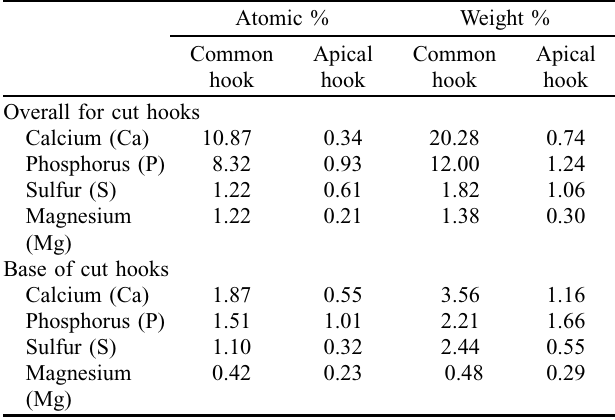
Table 3. Comparison of atomic % and weight % of elements of selected large hooks vs. apical